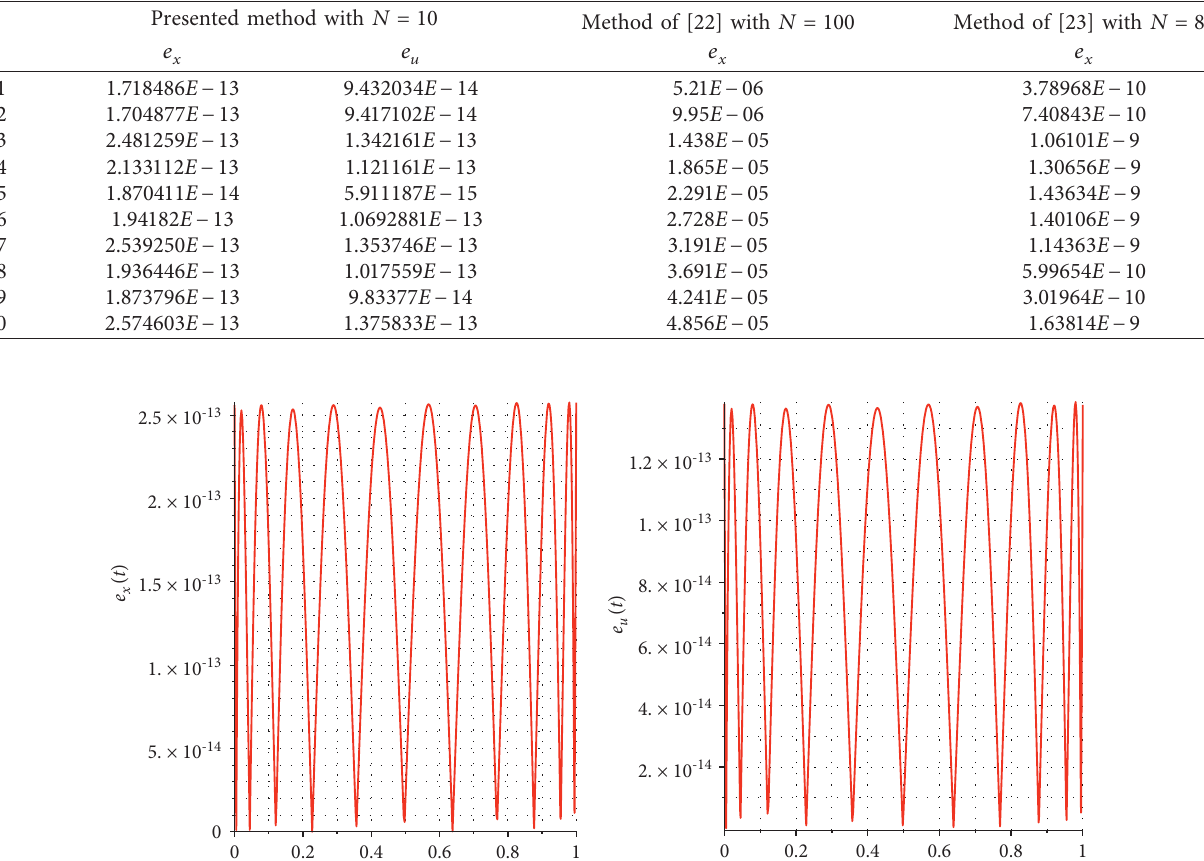
Table 2: Absolute errors of x ( . ) and u ( . ) with N � 10 in Example